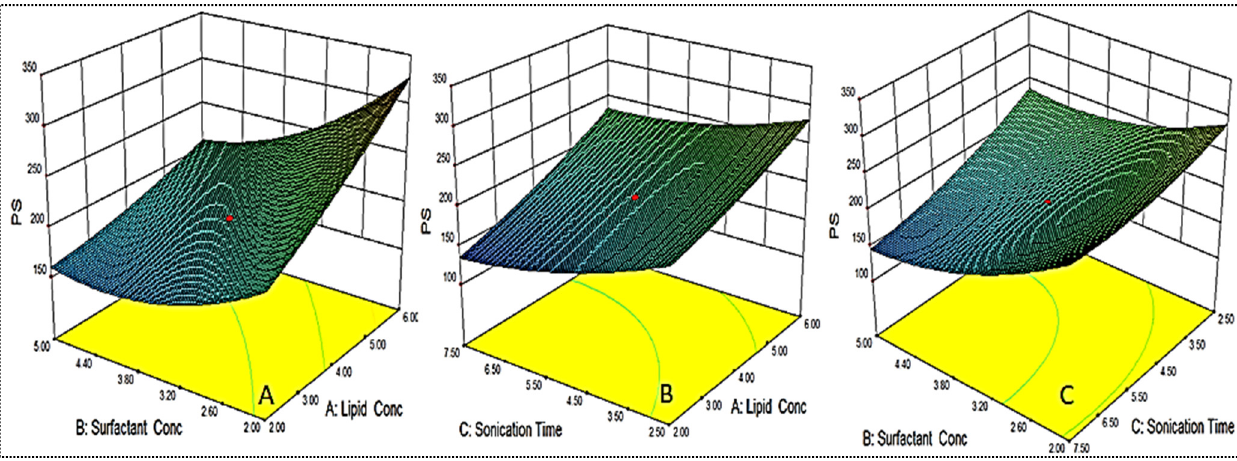
Figure 2. 3D response surface plot showing effect of factors lipid ( A ), surfactant ( B ) and sonication time ( C ) on the particle size (Y 1 ).